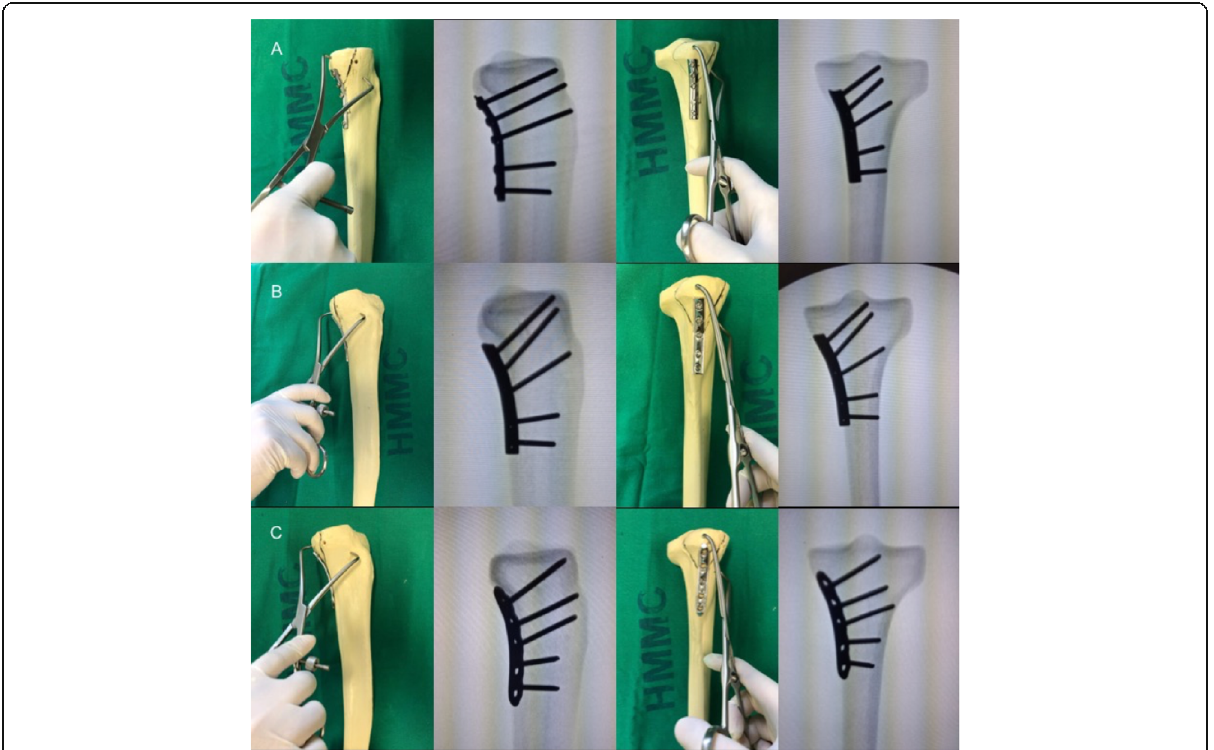
Fig. 2 a TTP specimen model, b DCP specimen model, and c LCP specimen model. Note the perfect contouring of the plates to the posteromedial surface of the tibial plateau. Anatomic reduction was warranted both by direct vision and fluoroscopic